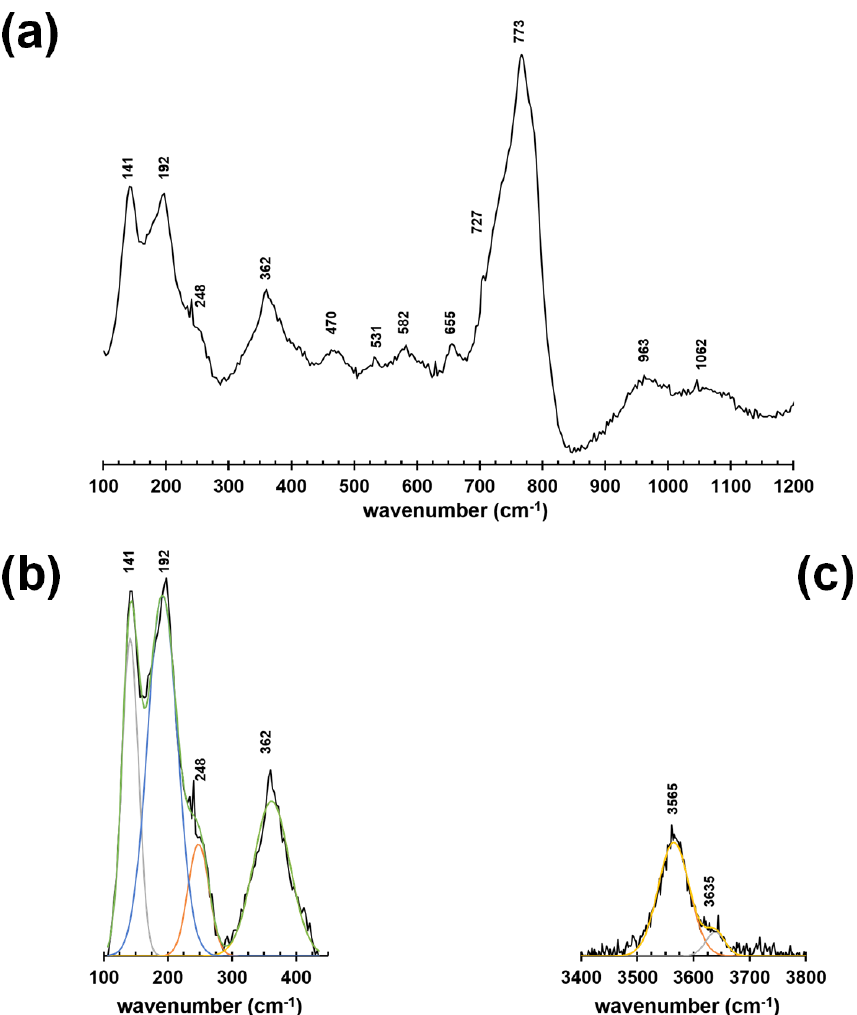
Figure 2. Raman spectrum of dutrowite (a) and fitting of the spectral region between 100 and 500cm − 1 (b) and 3400–3800cm − 1 (c) .